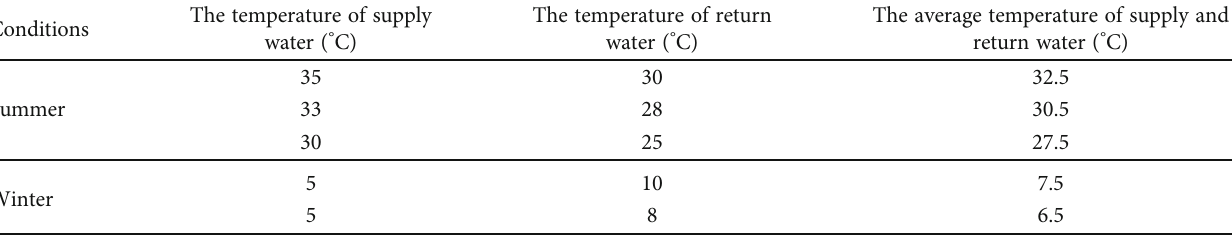
Figure 13: Relationship between the average temperature of supply water and heat transfer per unit hole depth of four test holes (a) and the relationship between the average temperature of supply water and single-hole heat transfer of four test holes (b). Note: “ - ” means taking heat from Table 3: The temperature conditions of supply and return water under simulated winter and summer conditions.